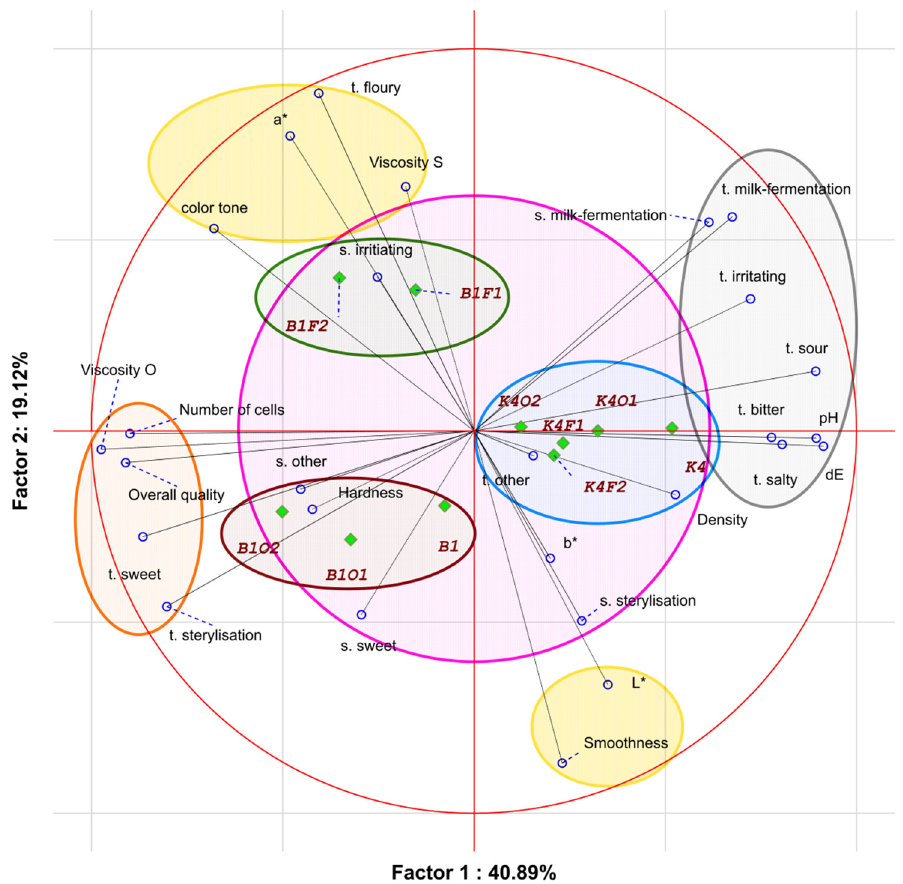
Figure 4. PCA analysis results shown via a projection of the variables and cases on the factor plane. The samples were coded according to Materials and methods section. The abbreviation ‘t.’ corresponds to taste, while ‘s.’ corresponds to smell; L*, a*, and b* correspond to color components.